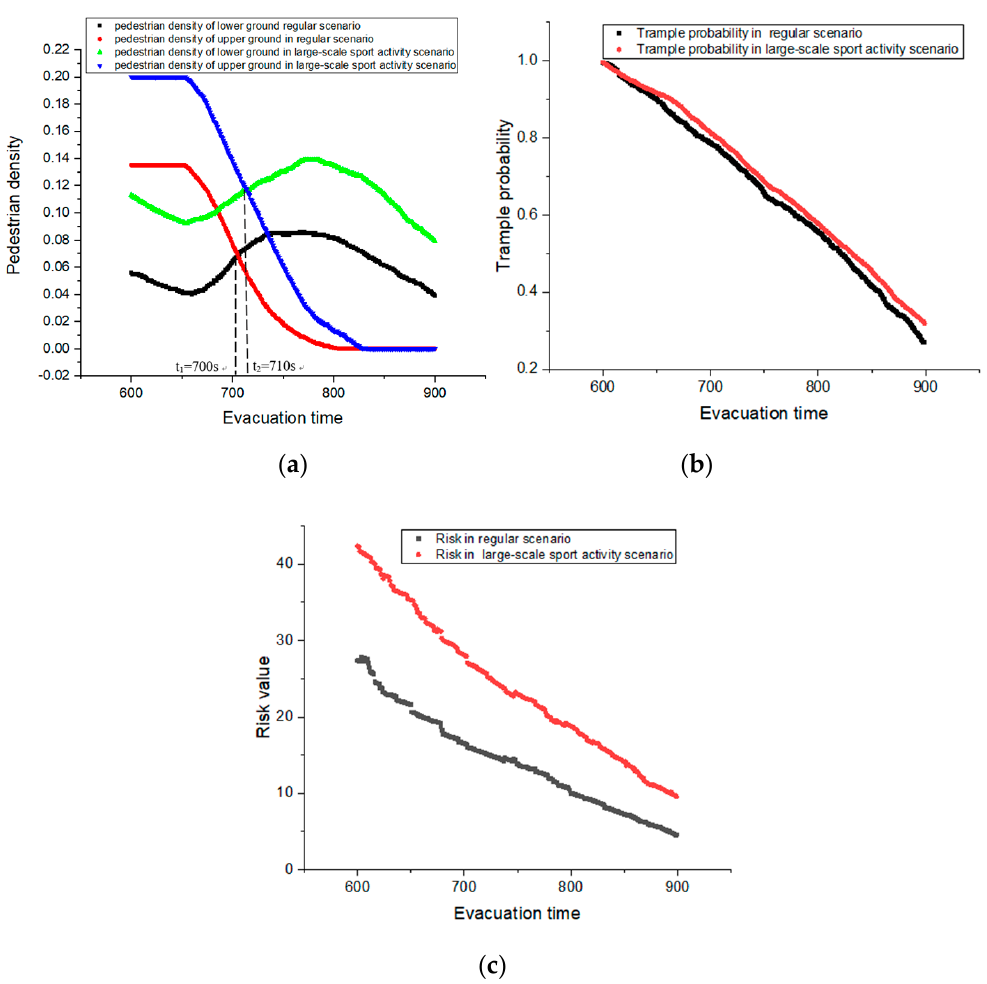
Figure 4. Random evacuation simulation: ( a ) pedestrian density changes, ( b ) trample probability changes, and ( c ) risk changes.